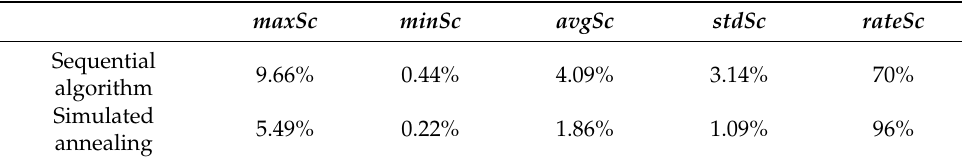
Figure 13. Comparison of score. Table 4. Score result statistics.